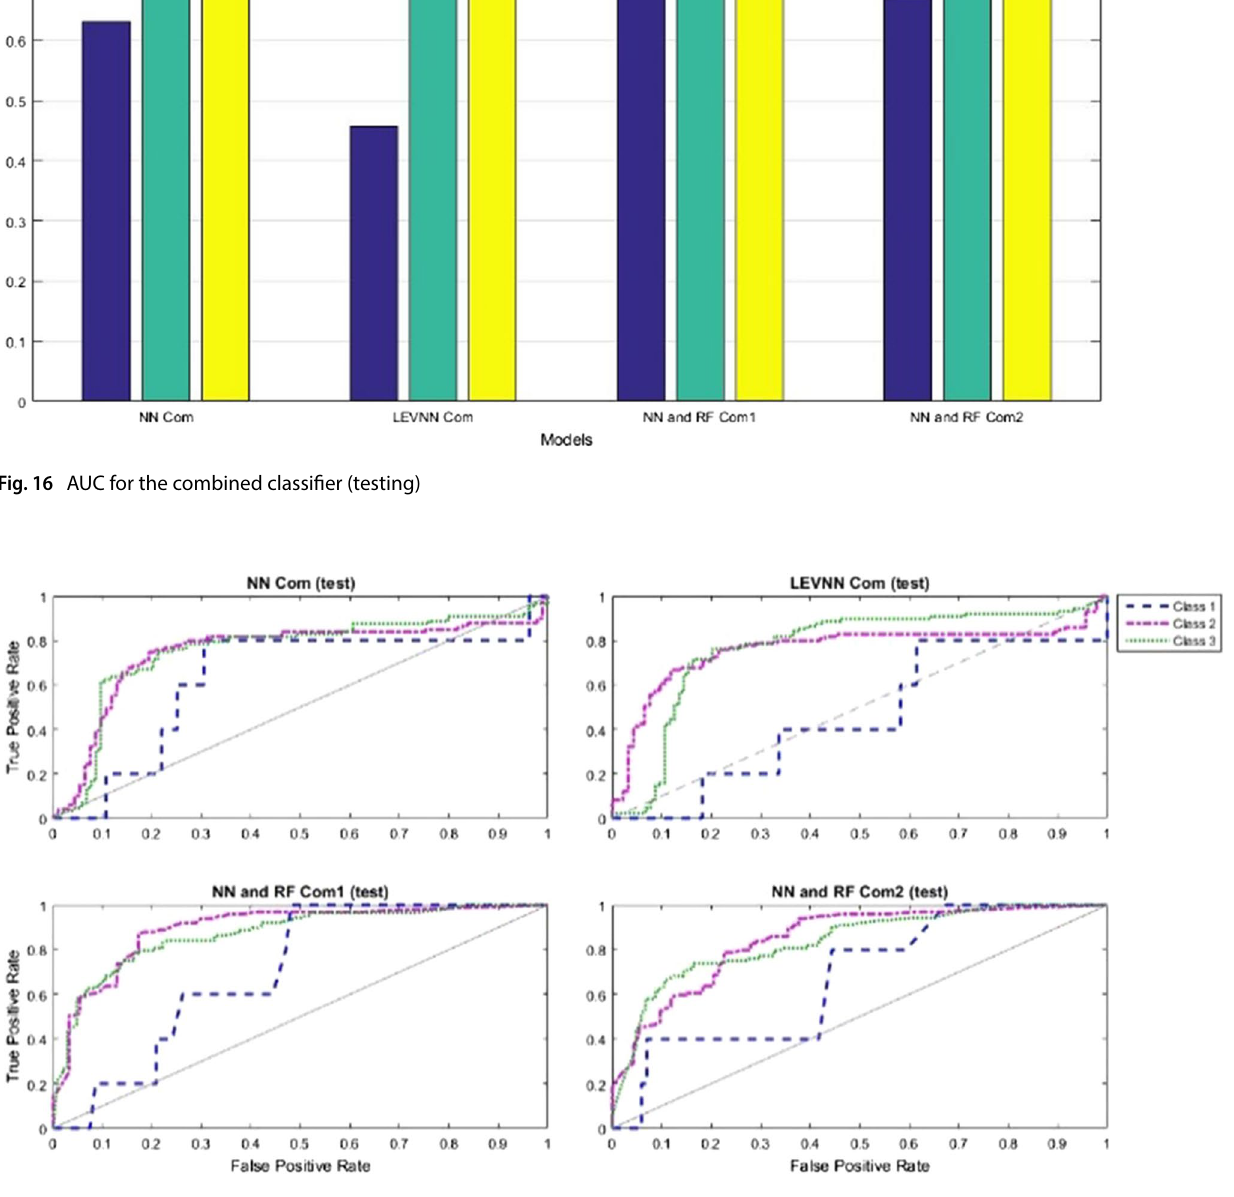
Fig. 17 ROC curve for the combined classifier